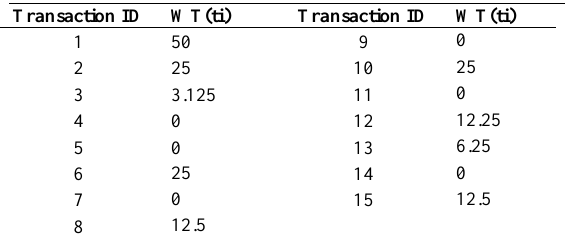
Table 4. Calculated weights for transactions.